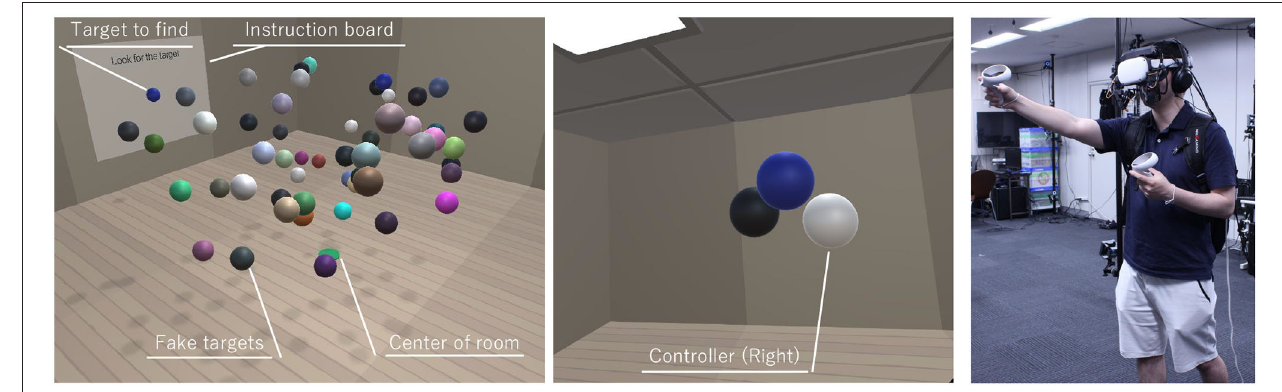
FIGURE 8 | Experiment 2 task. (Left) Virtual environment. Participants go to the center of the room. Then, an instruction board showed a target to find. The participants looked for the target among fifty spheres. (Center) Participant’s view. The participants can see controllers as spheres. (Right) The participants touched the target with the